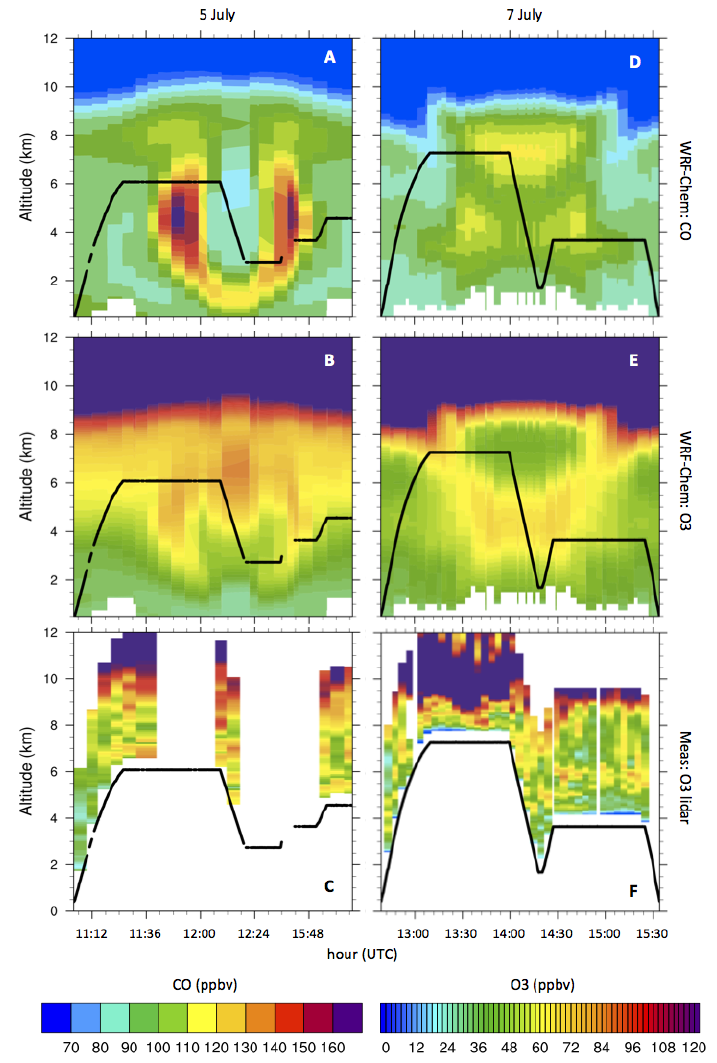
Fig. 10. Model results and measured lidar profiles from the ATR-42 flights on 5 and 7 July. Vertical cross sections of CO (a) and (d) and O 3 (b) and (e) along ATR-42 flight tracks extracted from WRF-Chem demonstrate the extent of plumes as modeled by WRF-Chem over southern Greenland. Bottom panel (c) and (f) shows ozone lidar plots from measurements made onboard the ATR-42 air- craft.